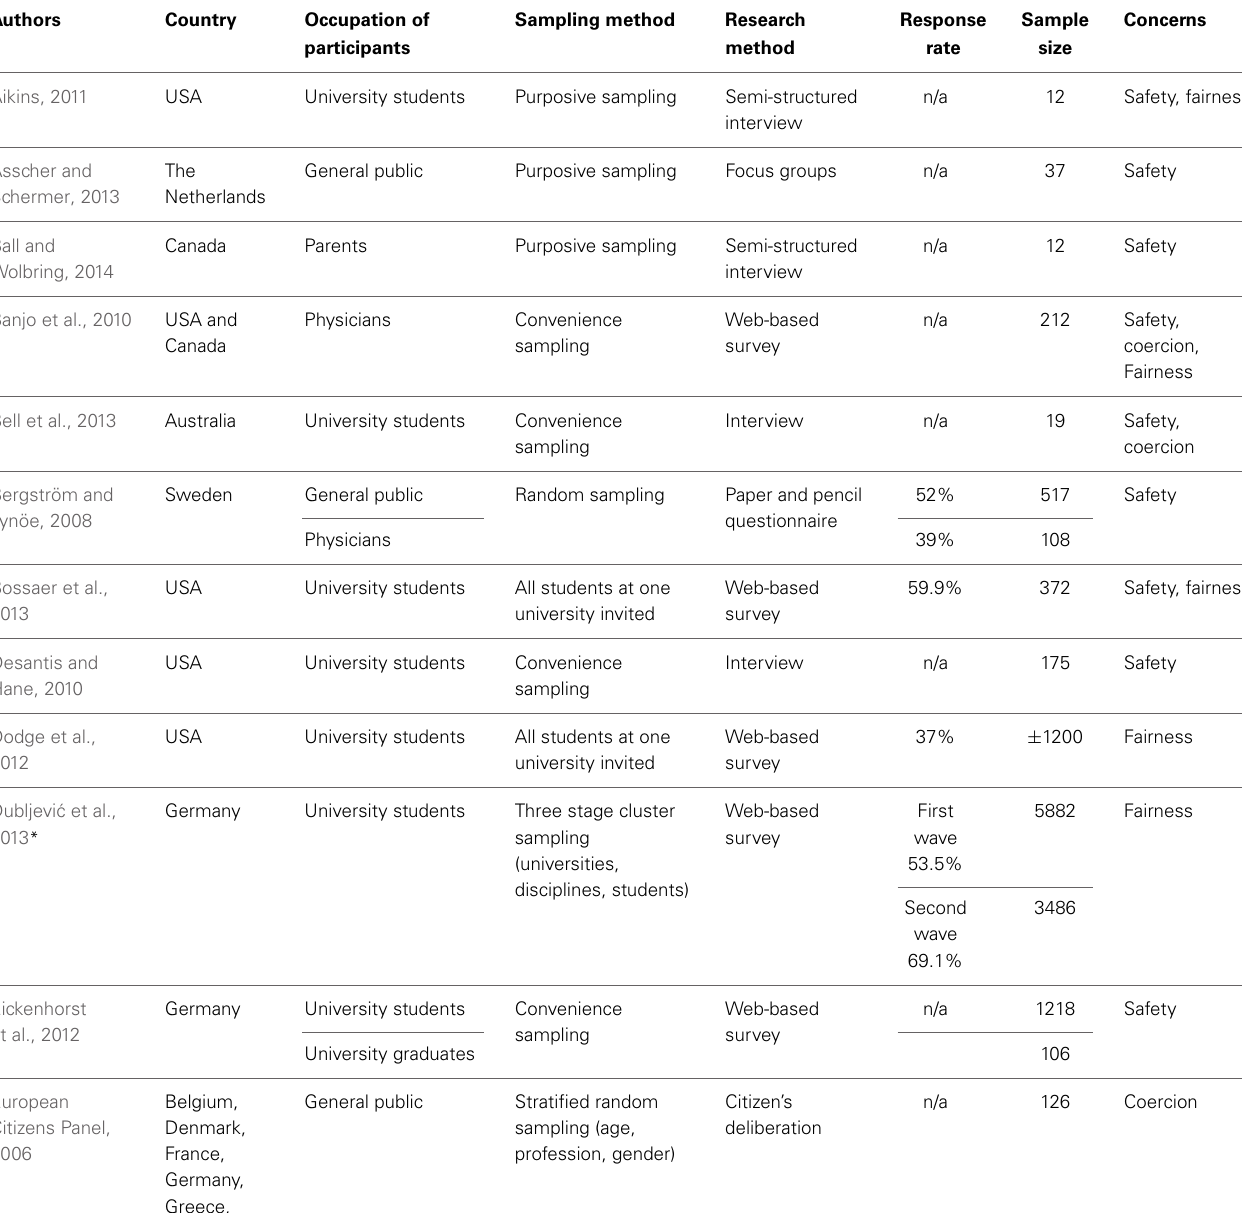
Table 1 | Overview of the empirical studies discussed in this